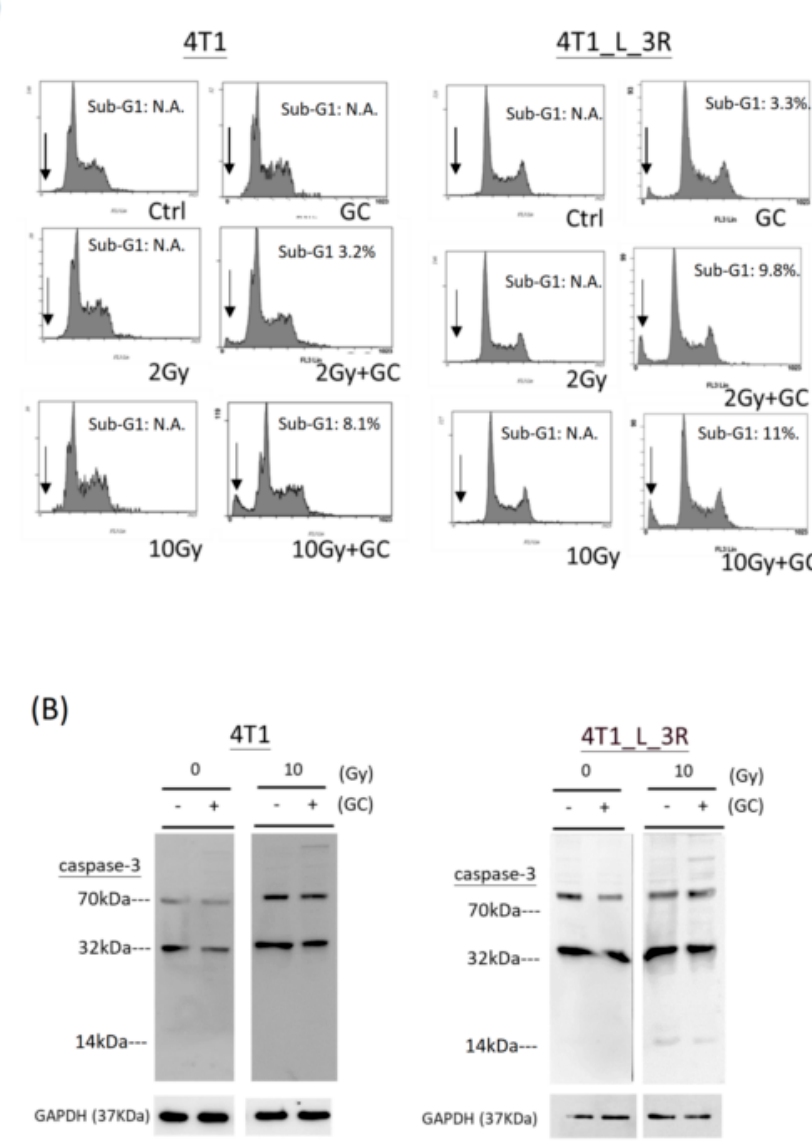
Figure 6. Effects of GC combined with different doses of X-rays on induction of apoptosis. ( A ) Analysis of sub-G1 population by flow cytometry. The arrows represent the peaks of sub-G1 population in the DNA histograms. The experiments were duplicated. N.A.: not available. ( B ) Western blot analysis of caspase-3 expression (~32 kDa) and cleavage (~14 kDa) in cells upon various treatments.